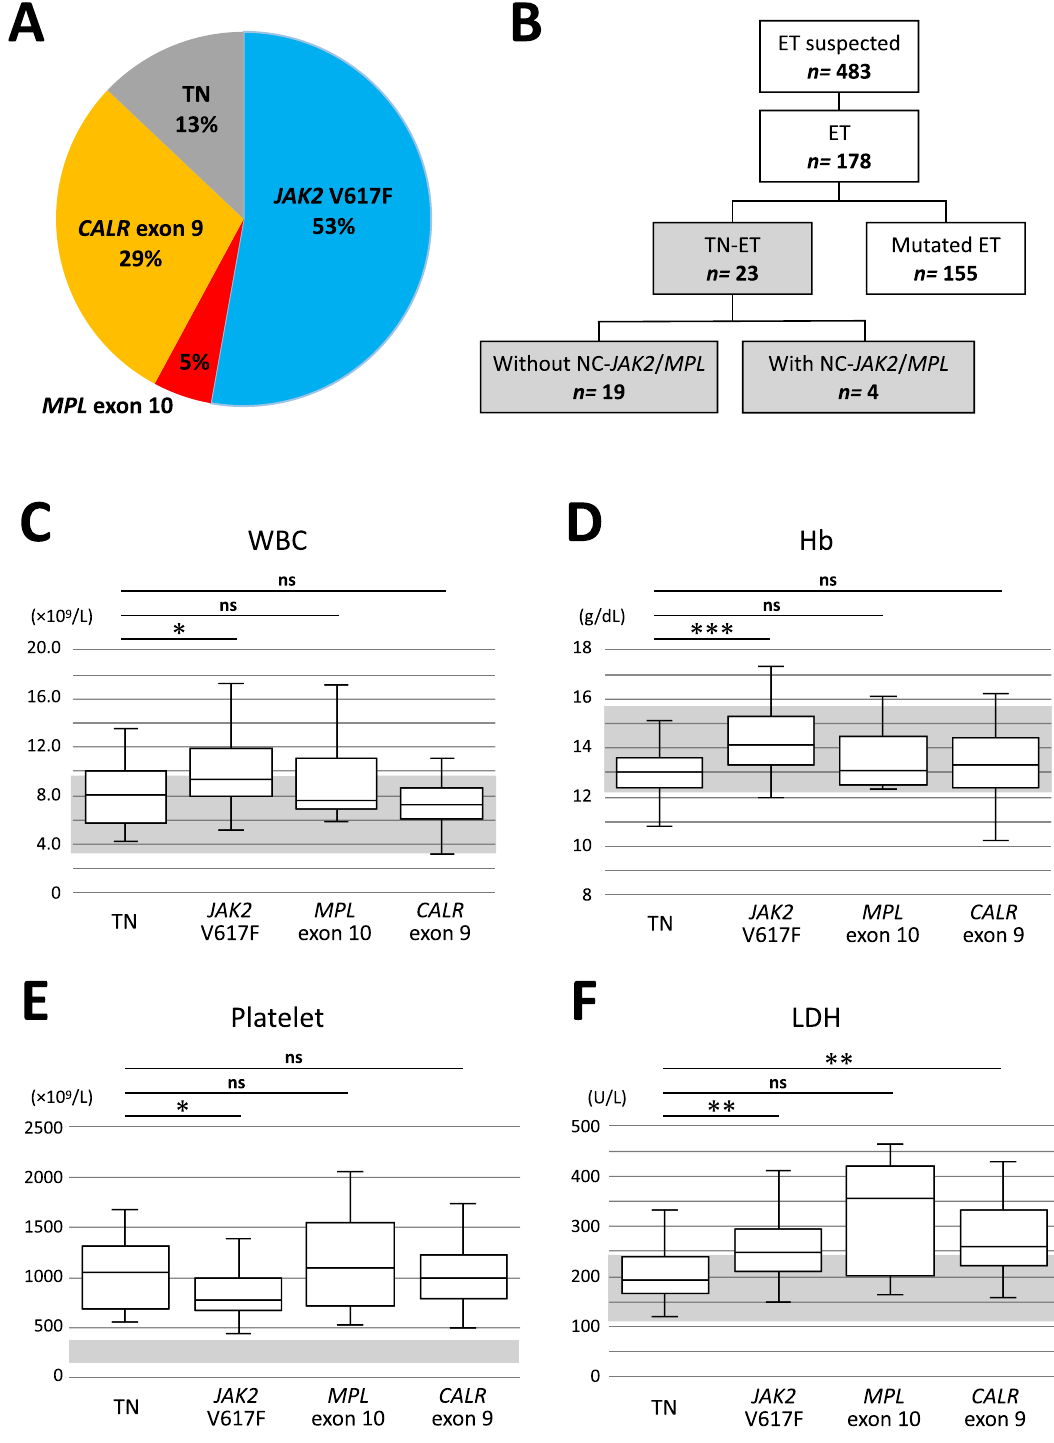
Figure 1. Comparison of clinical parameters between the TN-ET patients and mutated ET patients. ( A ) Frequencies of driver mutations in the ET patients in our cohort. ( B ) A diagram presenting the mutation profiles of the TN-ET patients. NC- JAK2 / MPL : noncanonical JAK2 and MPL mutation. The WBC count ( C ), Hb value ( D ), platelet count ( E ), and LDH level ( F ) for the patients classified based on driver mutation status are shown. Gray highlight shows normal range. * < 0.05, ** < 0.01, *** < 0.001, ns: not